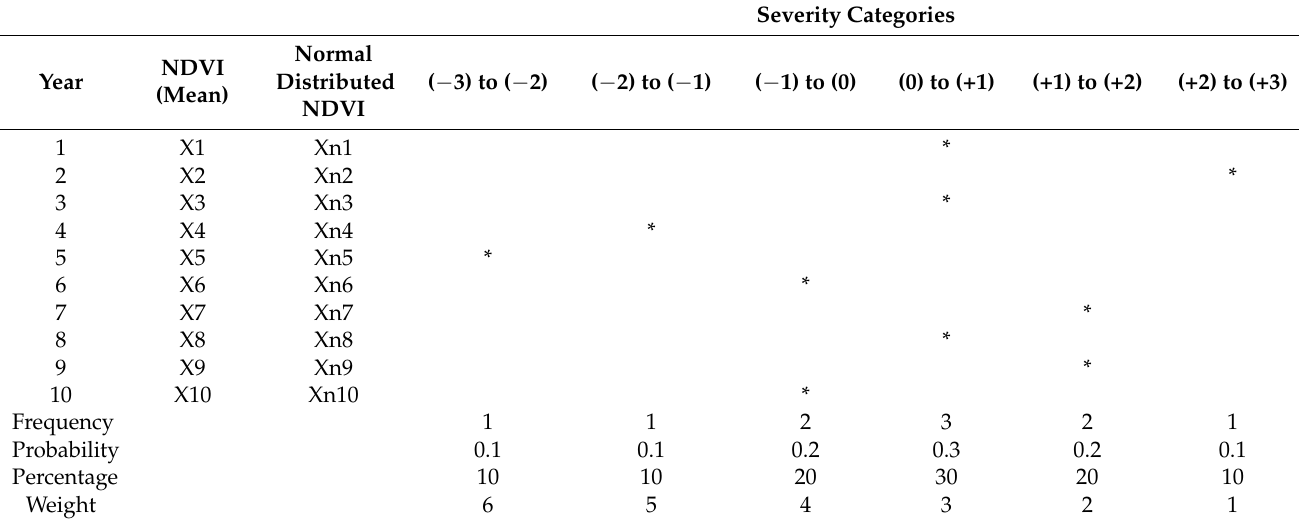
Table 1. Example of hazard quantification